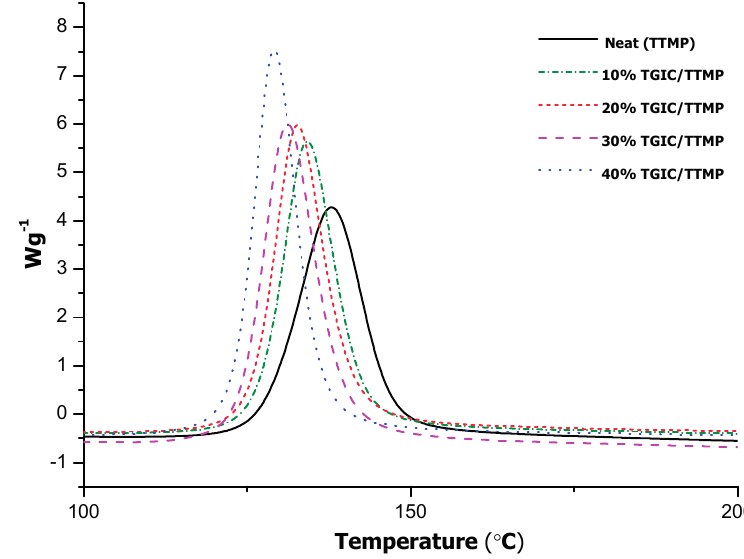
Figure 1. DSC thermograms corresponding to the dynamic curing at 10 °C/min of mixtures with TTMP and different proportions of TGIC catalyzed by 0.5 phr of LC-80.